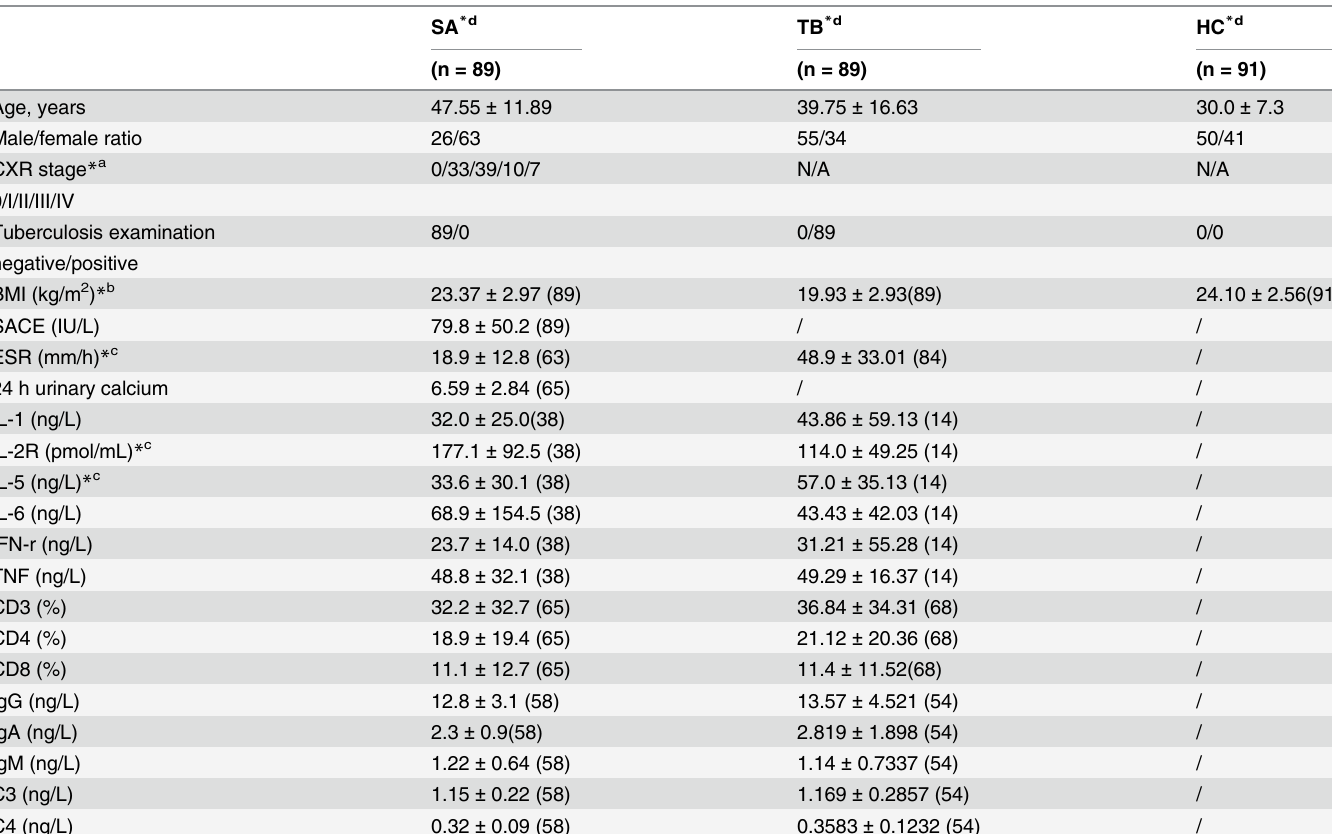
Table 2. General information and clinical indices of the SA, TB, and HC groups included in the ELISA